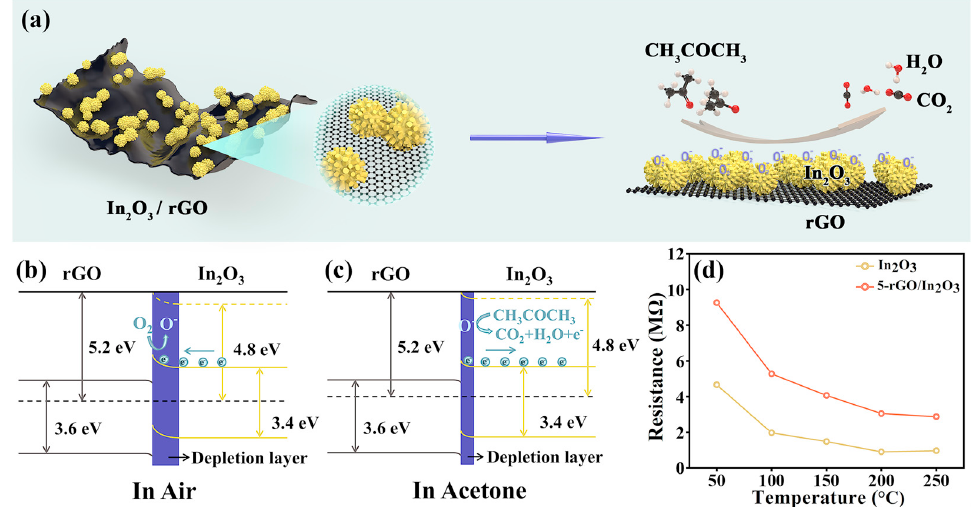
Figure 9. ( a ) Schematic diagram of the mechanism of the acetone gas-sensing process of the rGO/In 2 O 3 composites. ( b , c ) Schematics of energy band diagrams of rGO/In 2 O 3 heterojunctions. ( d ) The resistance of the sensors in air as a function of operating temperature.